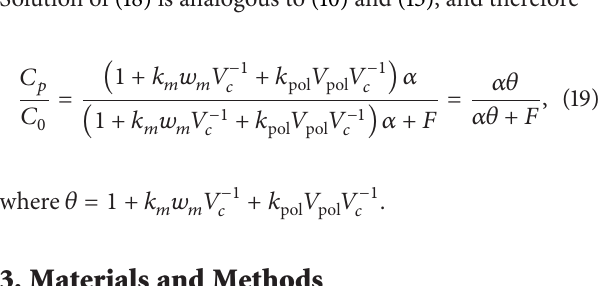
Table 1: Values of 𝑅